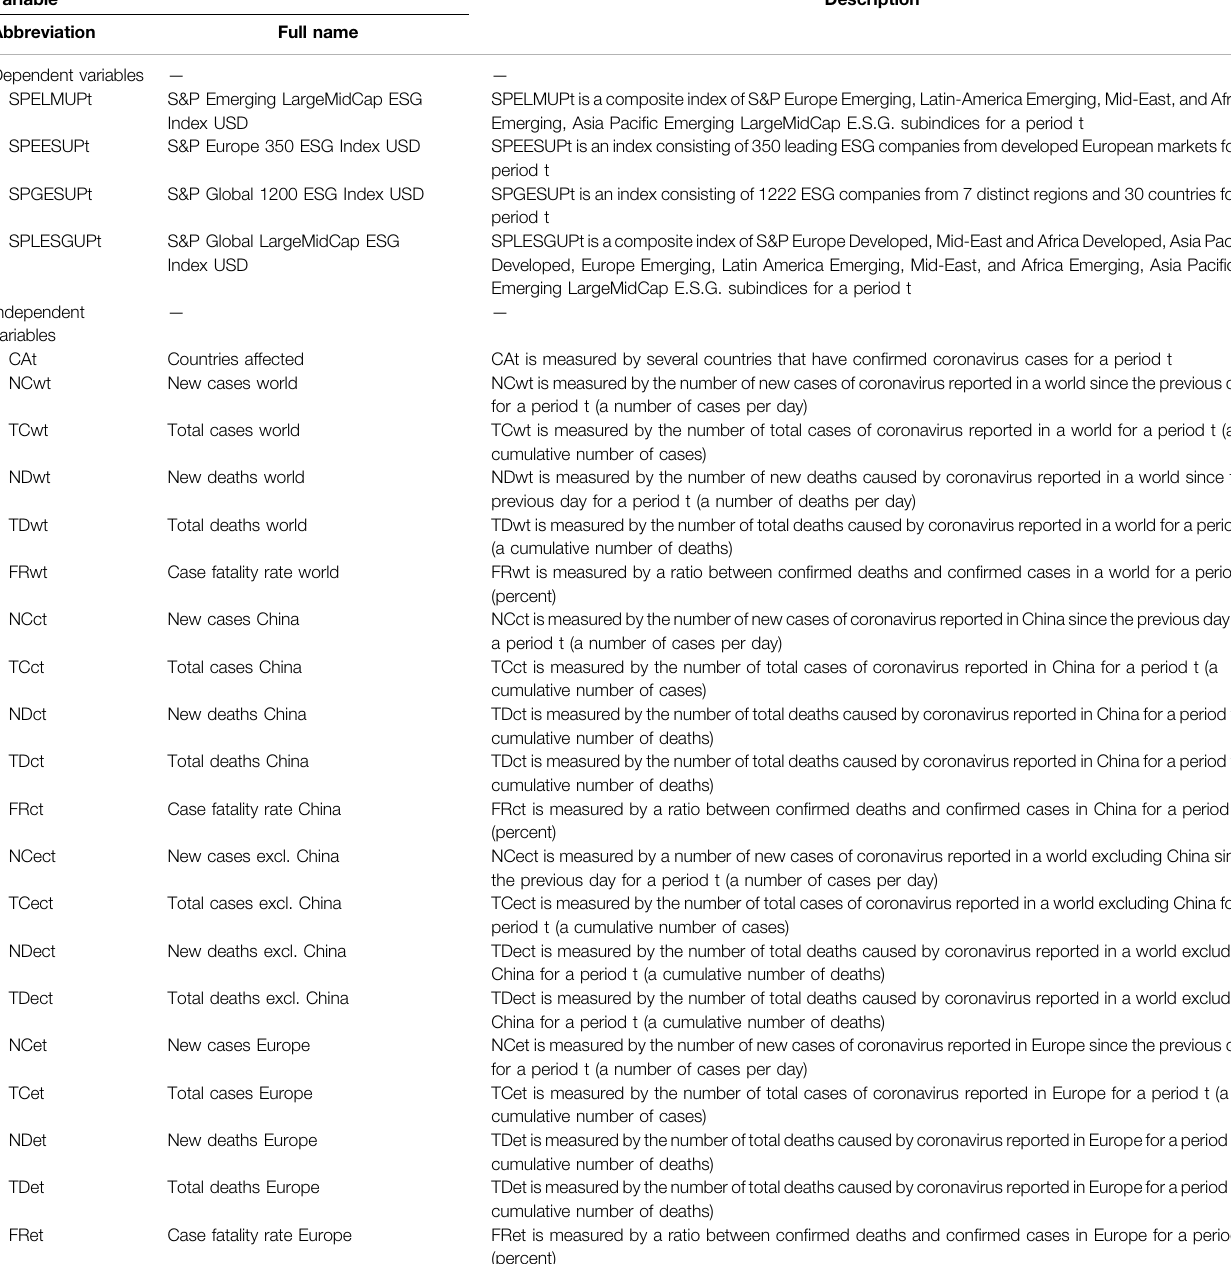
TABLE 1 | Variables of a regression model, abbreviations, and description. Variable